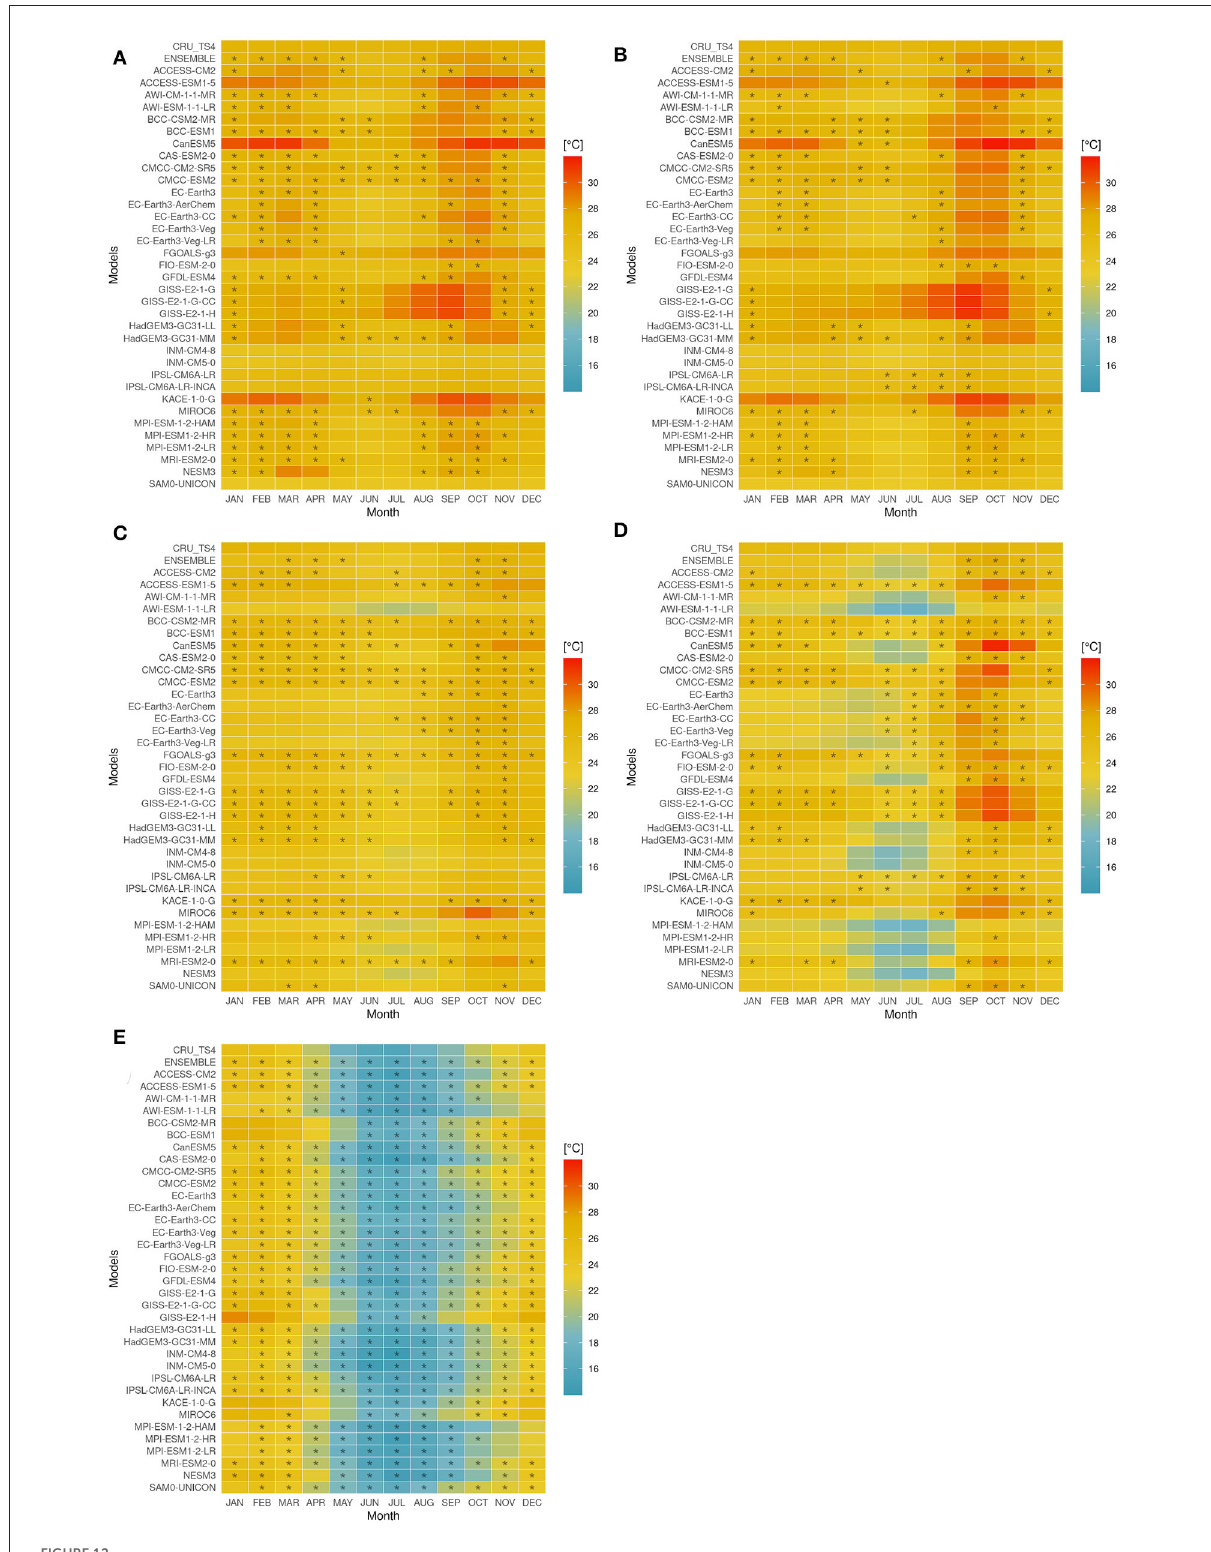
FIGURE12 Same as in Figure 11 but for